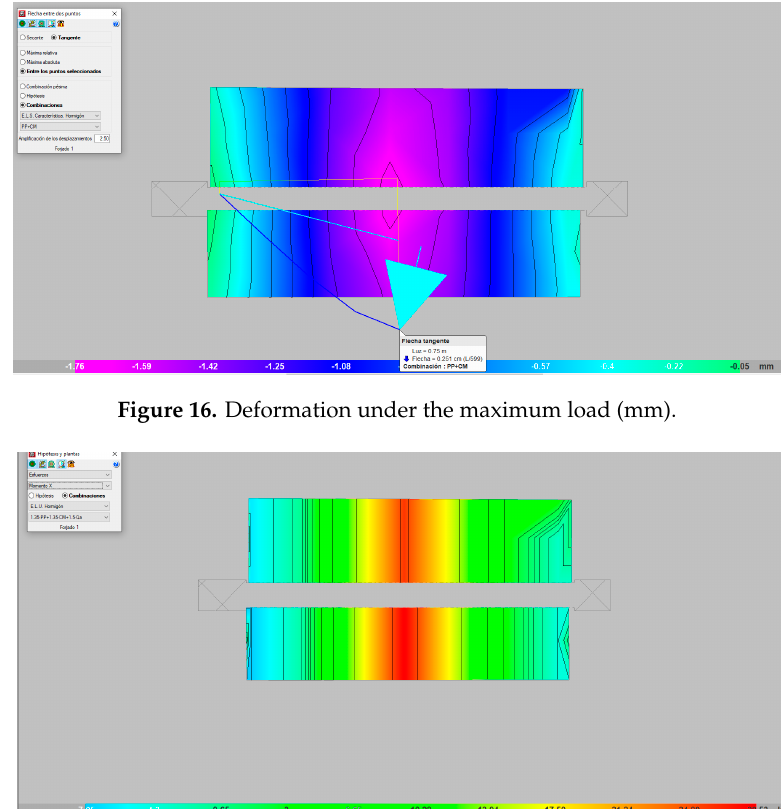
Figure 17. Moment on the x -axis (MPa).